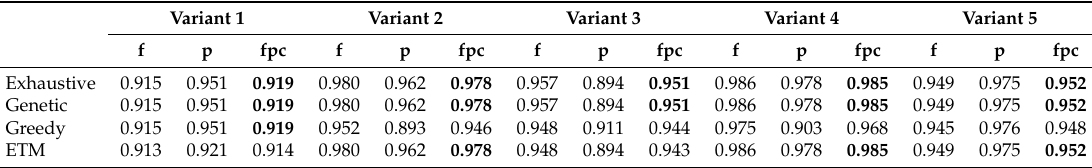
Table 6. Results for CPT 4-C and the event logs corresponding to the five process variants. Variant